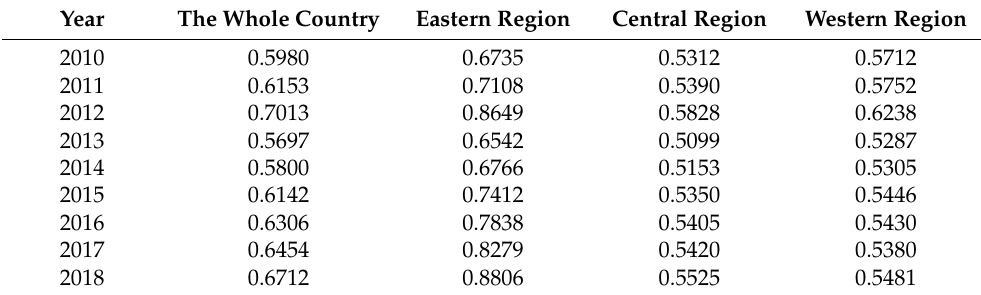
Table 1. Green total factor productivity calculation results in various regions during